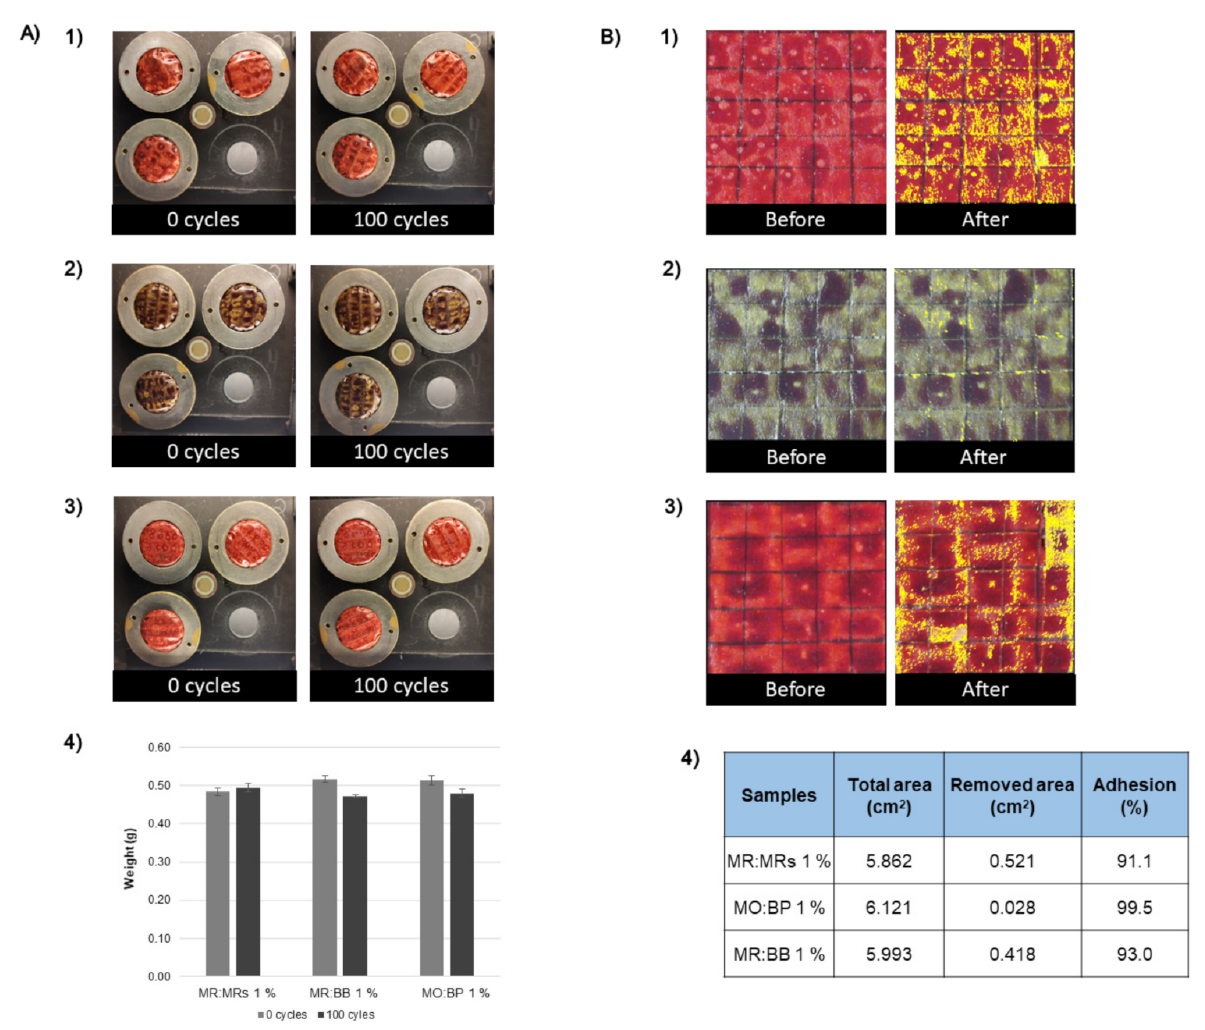
Figure 7. Results obtained for the ( A ) abrasion resistance of the samples ( 1 ) MR:MRs 1% ( w / v ), ( 2 ) MO:BP 1% ( w / v ), ( 3 ) MR:BB 1% ( w / v ), and ( 4 ) weight of samples before and after 100 abrasive cycles. Results obtained for ( B ) adhesion test of the samples ( 1 ) MR:MRs 1% ( w / v ), ( 2 ) MO:BP 1% ( w / v ), and ( 3 ) MR:BB 1% ( w / v ). The ( B4 ) percentage of the adhesion was calculated by the difference between total area and removed